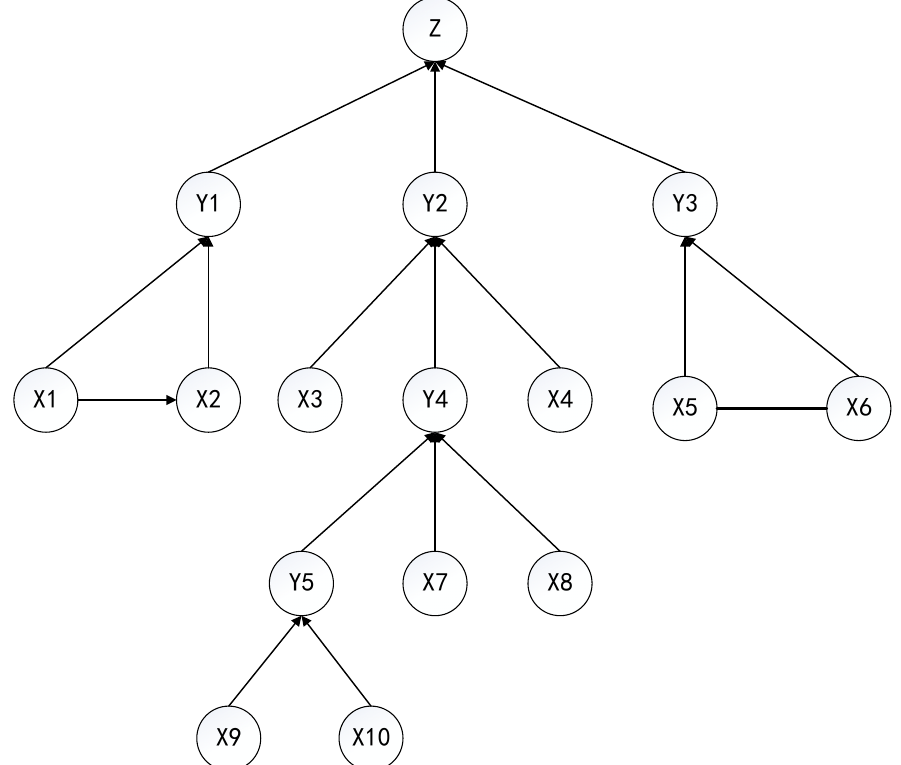
Figure 4. Equivalent Bayesian network model for automotive airbag systems.